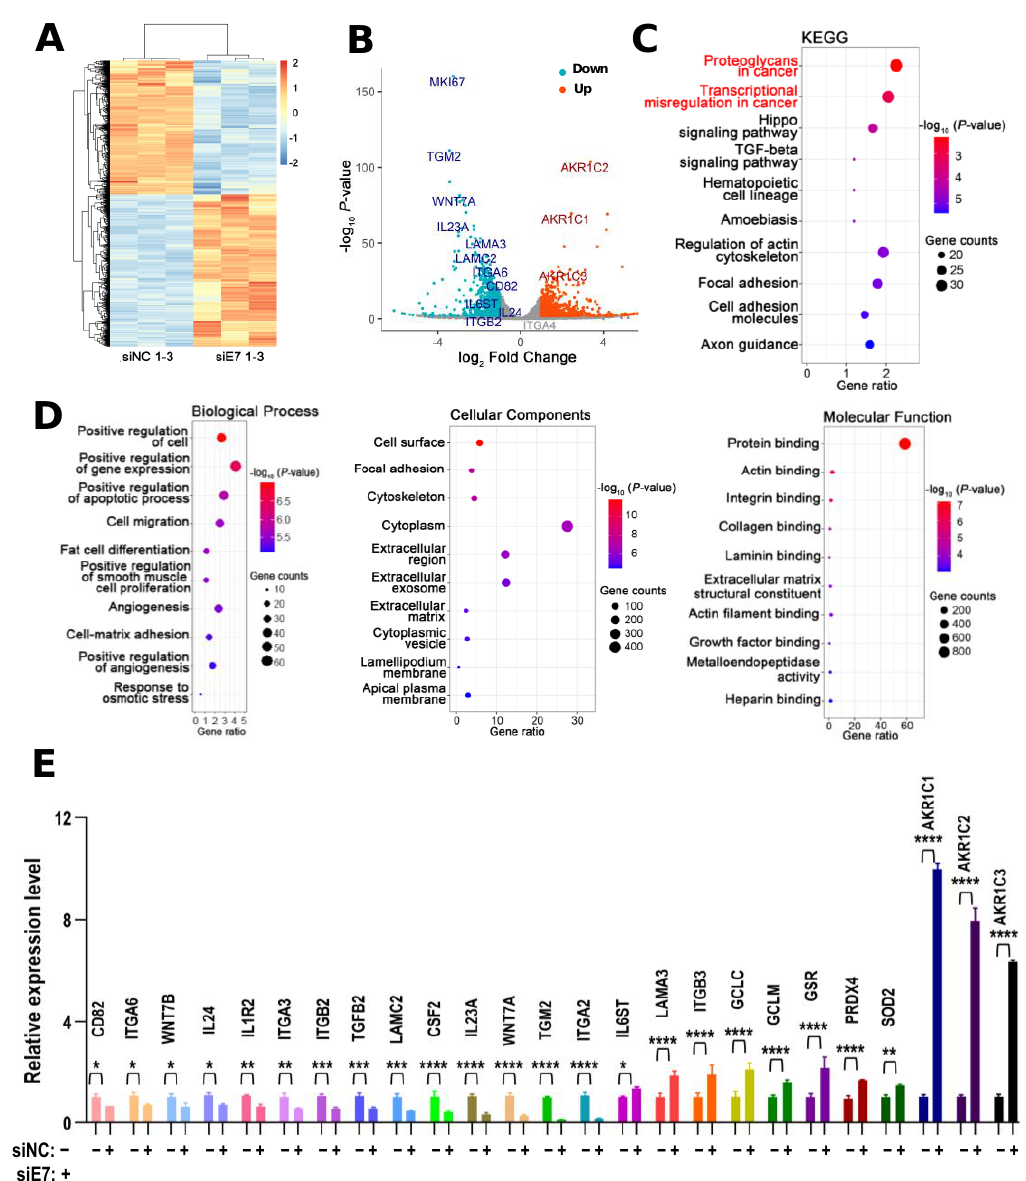
Figure 7. Cellular targets of Ki67 exon 7-included isoform in HNSCC cells. ( A ) The heatmap of the differentially expressed genes (DEGs) in SCC-9 cells with siE7 and siNC treated identified by RNA- seq. ( B ) The volcano plot of DEGs, each dot represents a gene. The red color denotes upregulated genes and the fluorescent blue color denotes downregulated genes. ( C ) KEGG pathways analysis of DEGs. ( D ) GO analysis of DEGs, including biological processes (BP), cell component (CC), and molecular function (MF). All the KEGG and GO graphs show the top 10 significant terms. The x-axis is the percent of DEGs enriched in the KEGG pathways or GO terms, and the y-axis is the corresponding KEGG pathway or GO term names. The bubble size represents the number of differentially expressed genes, and the bubble color represents the p -value. ( E ) Twenty-five DEGs were verified by qRT-PCR. * p < 0.05, ** p < 0.01, *** p < 0.001, **** p < 0.0001.